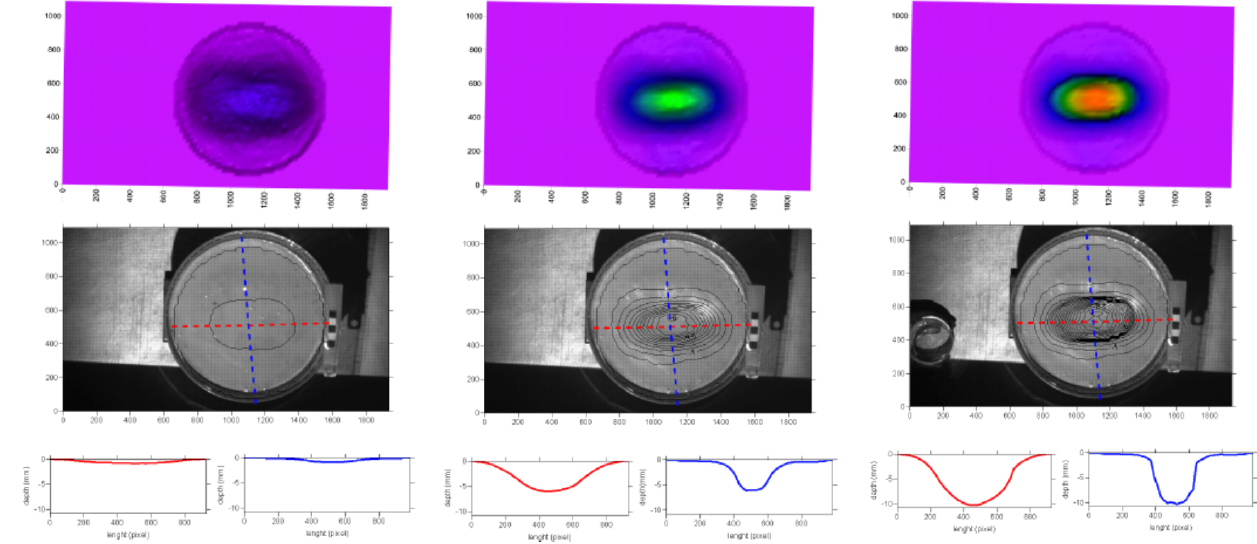
Figure 4. Example of the model results at the start, middle and end of the experiment. The images show the digital elevation model obtained with the ZEBRA software, a photograph of the model with overlapped contours and the topographic profile obtained in two orthogonal